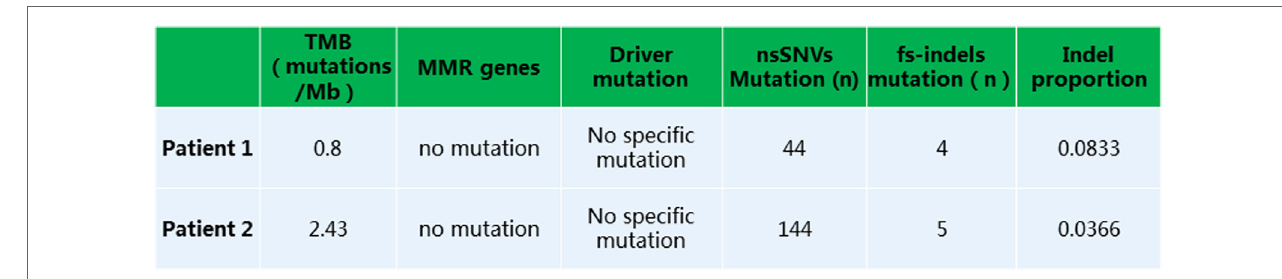
FIgURe 3 | Whole exome sequencing analysis revealed a low tumor mutation burden, lack of mutation in MMR or driver genes, and presence of non-synonymous single nucleotide variants or fs-indels.